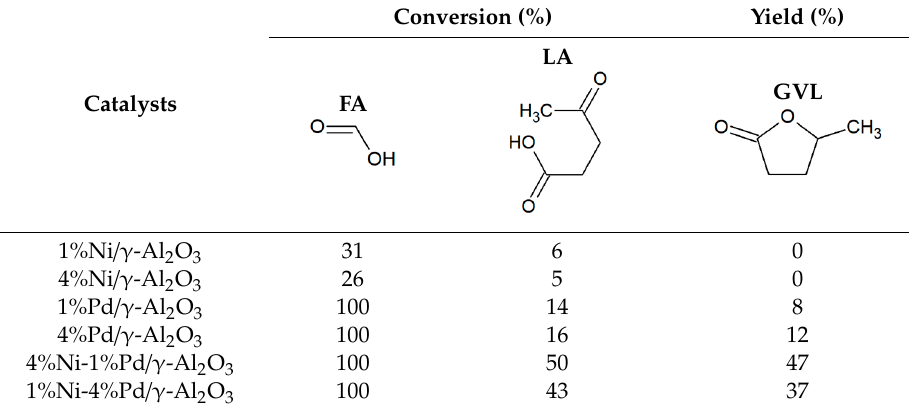
Table 3. Activity of mono- and bimetallic Ni-Pd/ γ -Al 2 O 3 catalysts in the simultaneous FA decomposition and LA hydrogenation into GVL, expressed in terms of both FA and LA conversions and of GVL yield. Yield (%) LA FA Catalysts